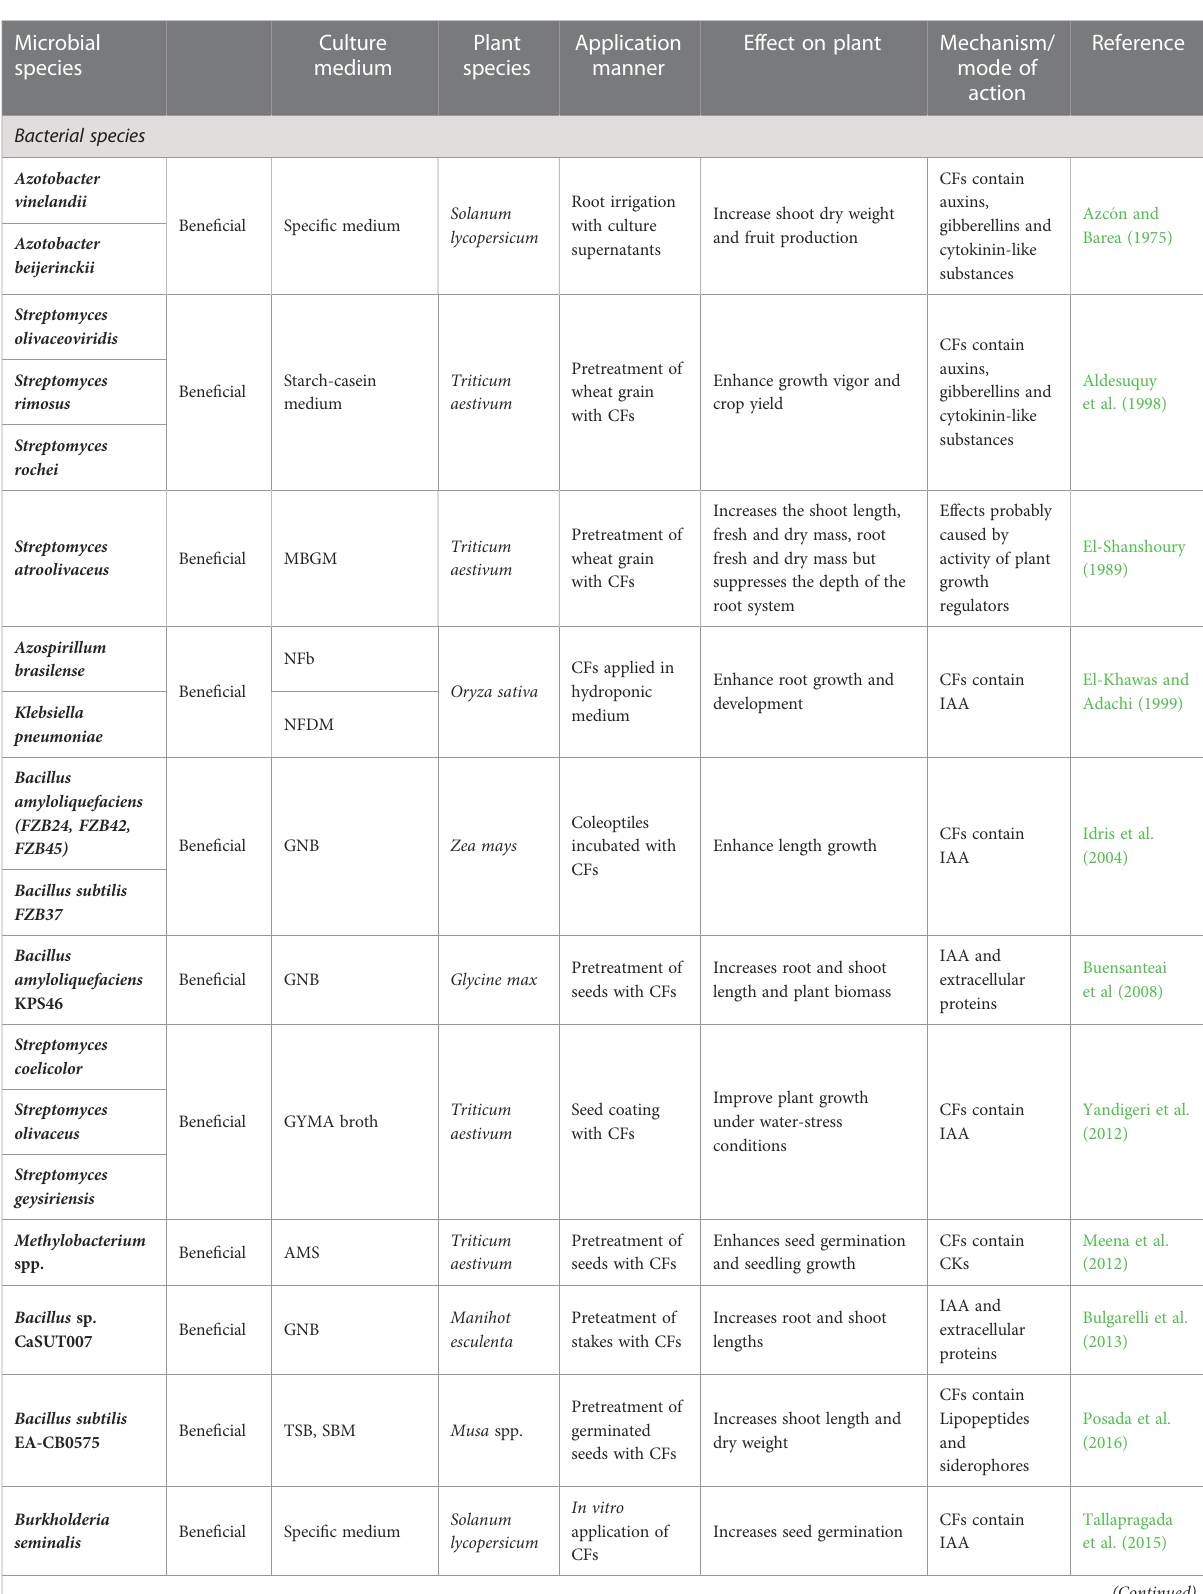
TABLE 2 Studies on effects of microbial CF application on plant.